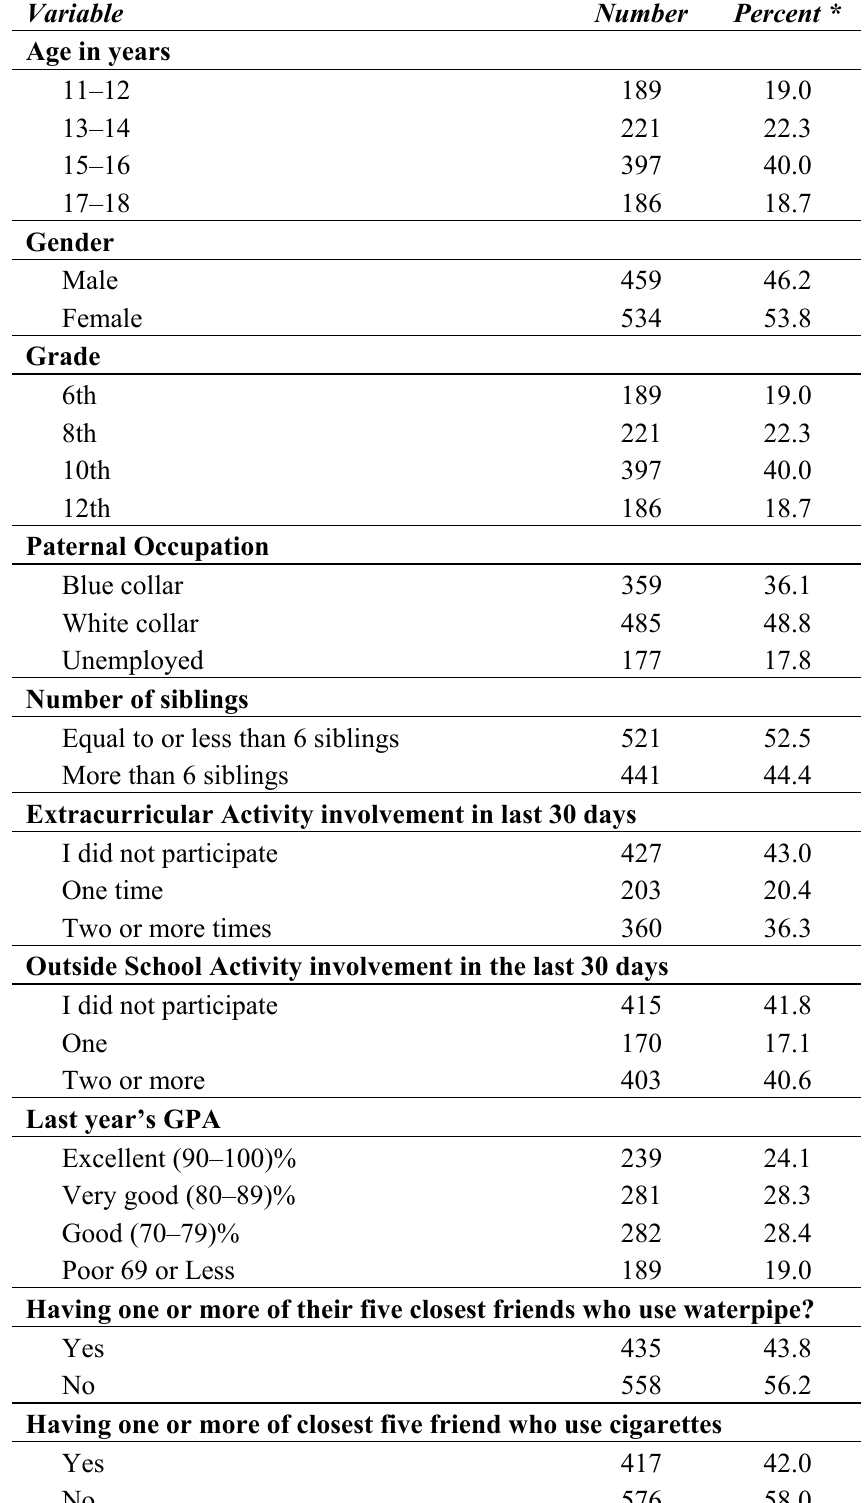
(Table 2), with similar percentages of boys and girls being cigarette-only or waterpipe-only users, but girls being almost twice as likely as boys to be dual users (34.3% and 17.0%, respectively). Table 1. Sample Characteristics ( N =